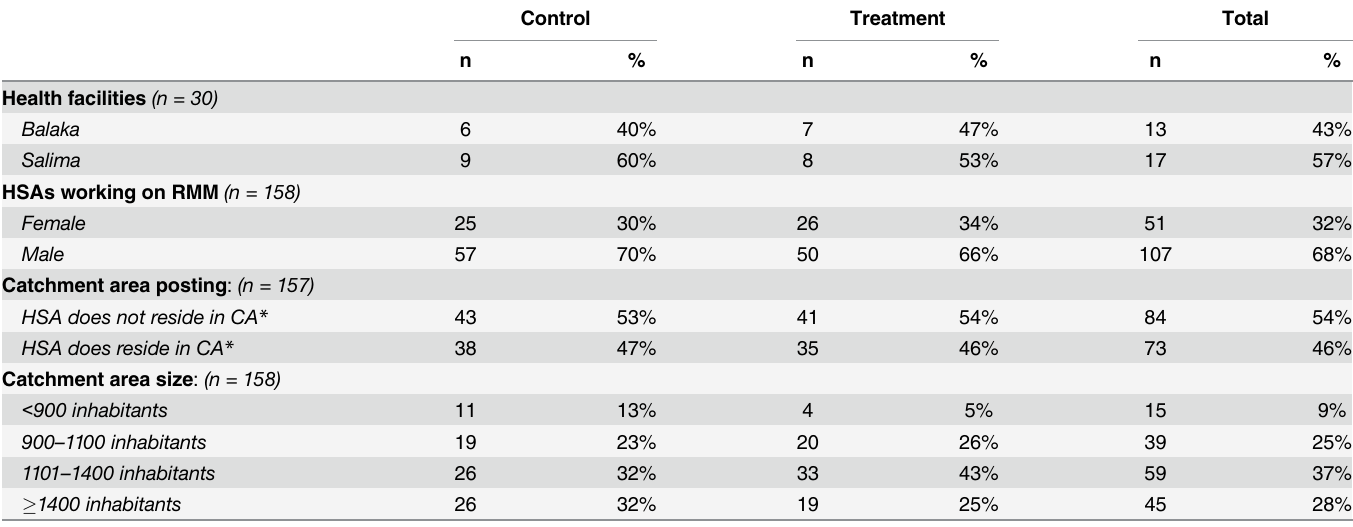
Table 2. HSA characteristics by